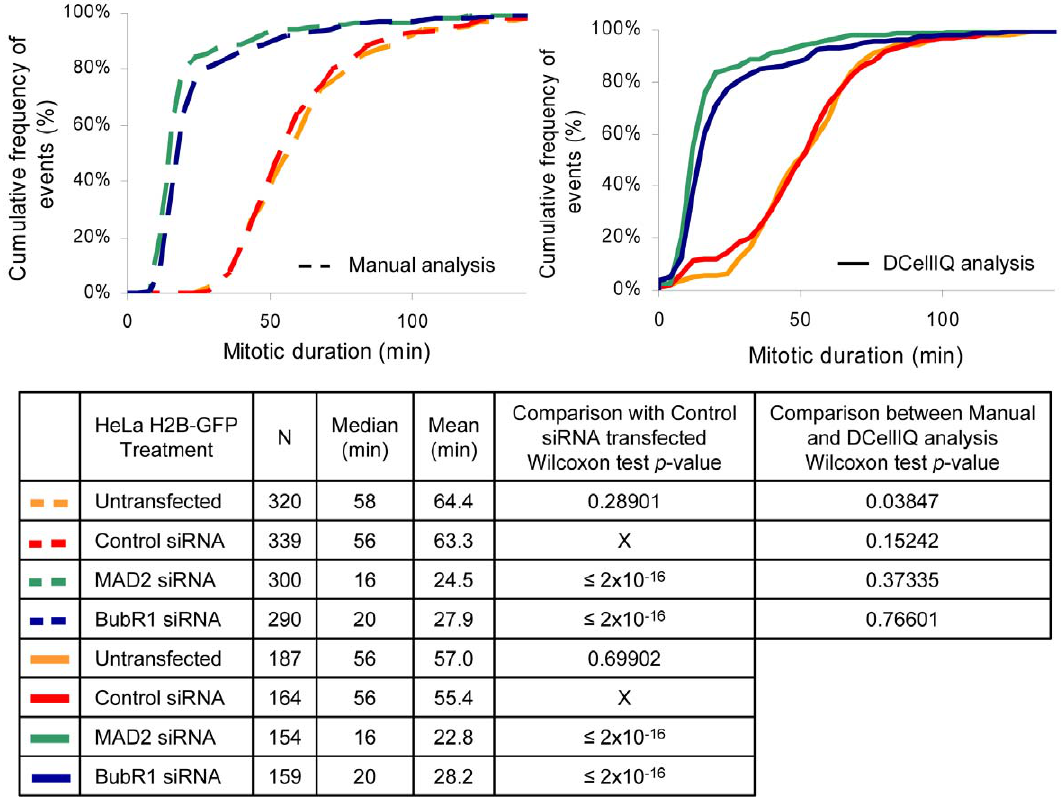
Figure 5. TSA detects decreases in mitotic duration when the spindle assembly checkpoint is inactivated. HeLa H2B-GFP cells were untransfected or transfected with non-targeting control, MAD2 or BubR1 siRNAs and were imaged 24 hours post-transfection, every 4 min for 48 hours. For each condition, 3 fields in 2 independent wells were imaged and the results for the 6 image series were combined. Image series were analyzed using DC ELL IQ and half of the movies were also analyzed manually. Cumulative frequency curves for the cell populations are